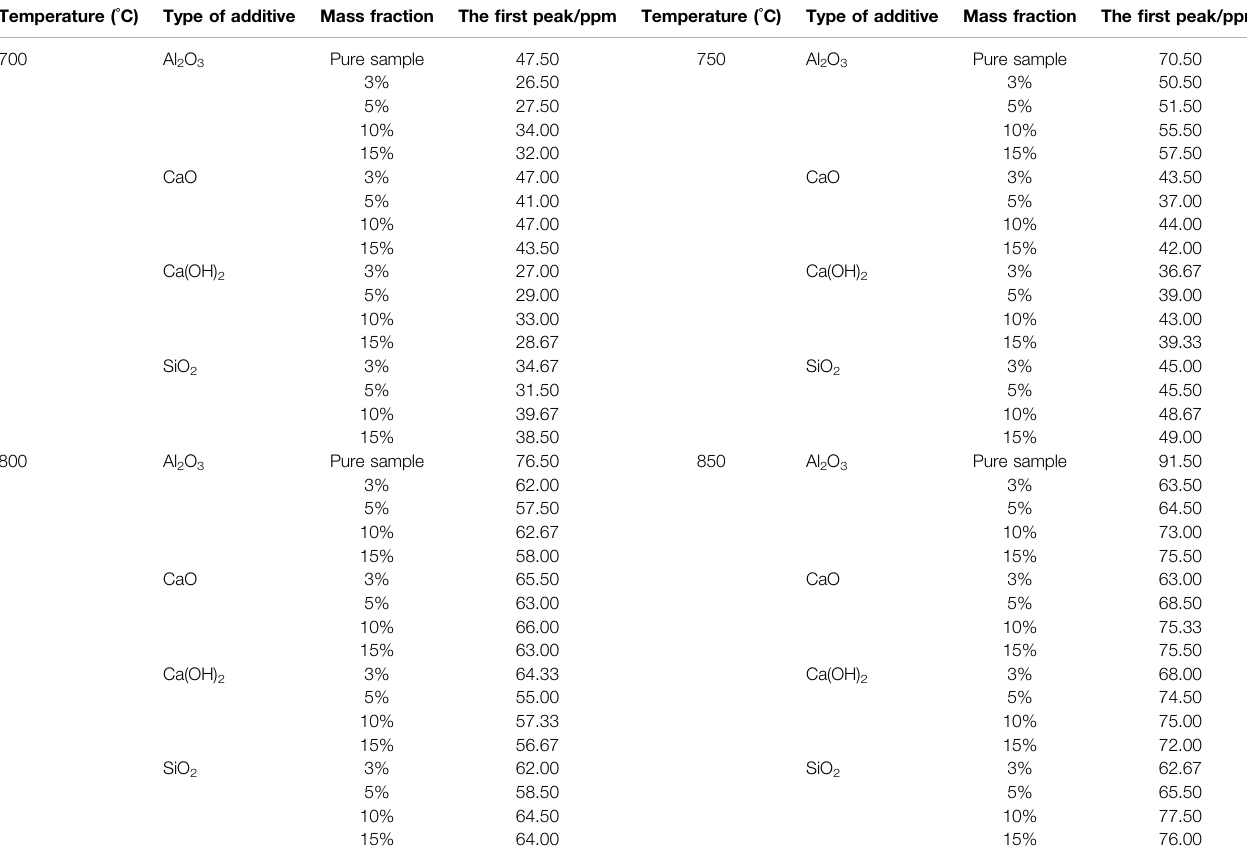
TABLE 3 | The fi rst peak for NO x emission from fast-growing grass combustion using different mass fractions of additives at different